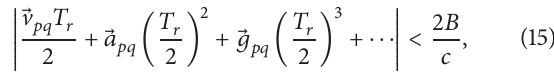
Figure 1: Monostatic missile-borne SAR geometry. ⃗𝑄 − ⃗𝑃 where ⃗𝑟 0 = 0 0 represent the initial vector between ⃗𝑄 ⃗𝑃 radar and target and ⃗ V 𝑝𝑞 ⃗𝑎 𝑝𝑞 , and ⃗𝑔 𝑝𝑞 refer to the relative velocity, acceleration, and jerk vector between radar and the target,